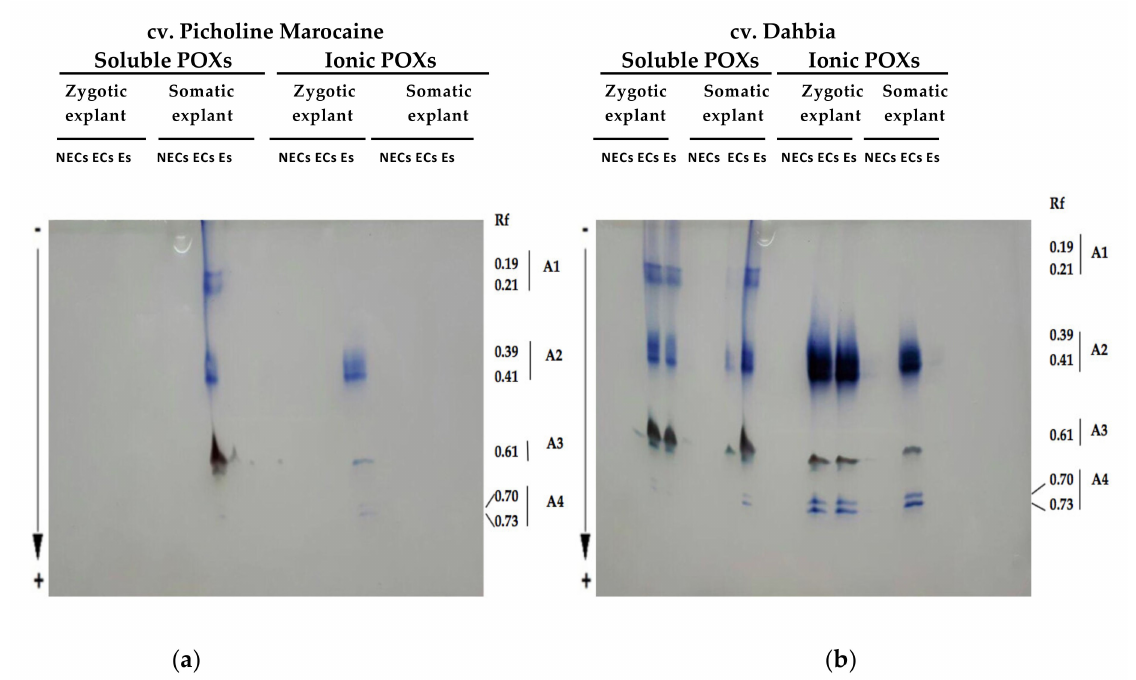
Figure 4. Zymograms of the soluble and ionically wall-bound peroxidases (POXs) of the olive cvs. Picholine Marocaine ( a ) and Dahbia ( b ) obtained by electrophoresis on polyacrylamide gels. Enzyme fractions were extracted from the nonem- bryogenic calluses (NECs), embryogenic calluses (ECs), and somatic embryos (Es) derived from the zygotic and somatic explants of each